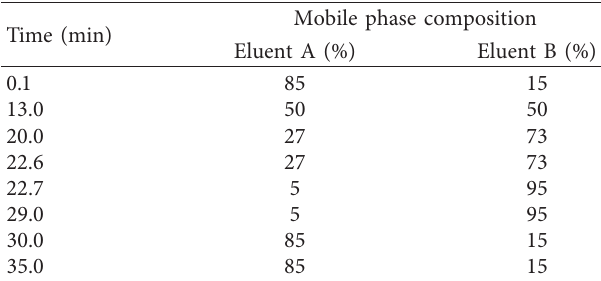
Table 1: HPLC gradient condition for the separation of biogenic